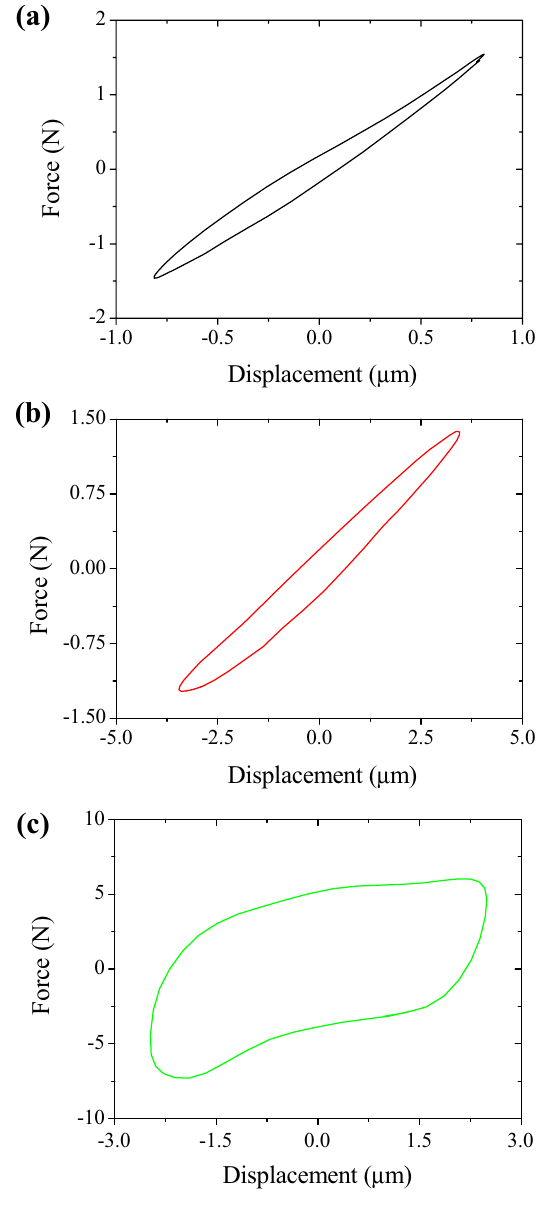
Figure 6. Hysteresis loops of ( a ) EPS, ( b ) EPDM, and ( c ) the probabilistic